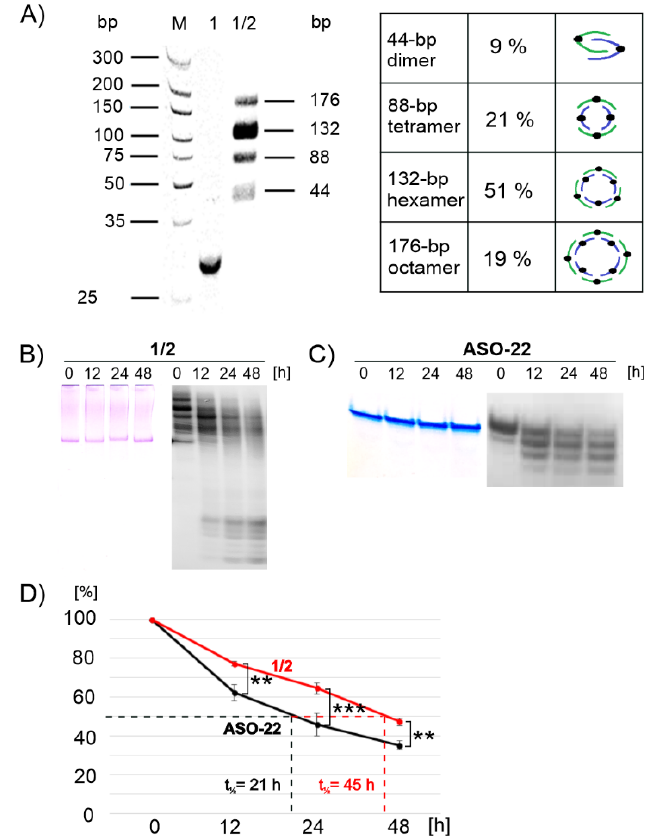
Figure 2. Analysis of the assembly ( A ) and stability of nanostructures 1/2 ( B , D ) in comparison to the stability of the reference oligonucleotide ASO-22 ( C , D ) in DMEM cell culture medium (left panels of ( B ) and ( C )), and in A431 cell lysate (right panels of ( B ) and ( C )) at 37 °C. Electrophoretic analysis of the assembly of oligopeds 1 and 2 annealed at a 1:1 molar ratio was performed using a nondenaturing 15% polyacrylamide gel and visualized by Stains-All staining (( A ), lane of dsDNA size marker–M, and ( B ) and ( C ), left panels) or by autoradiography (( A ), and lanes for 1 and products of assembly of tripeds 1 and 2 , and ( B ) and ( C ), right panels). The plot of the data in the right panels of ( B ) and ( C ) (degradation of the reference ASO-22 and 1/2 assembly products) is shown in ( D ). ** P ≤ 0.01, *** P ≤ 0.001 (Student’s t-test).